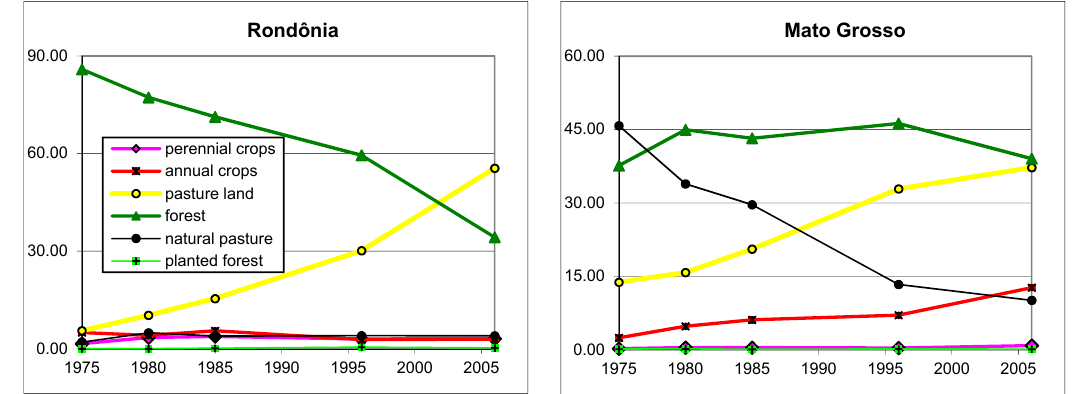
Figure 5. Changes of land use/cover change based on regionalized historical census data in Rondônia and Mato Grosso from 1970 to 2006, where the land use changes on perennial crops, annual crops or planted pasture were based on municipalities of clusters, taking into account the increase of the target land use type between 1996 and